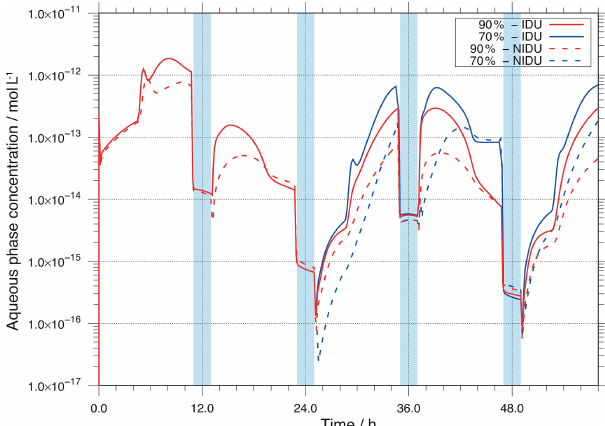
Figure 7. Modelled OH aqueous-phase concentrations in molL − 1 throughout the simulation time for the different urban simulation cases (90%-IDU / 90%-NIDU and 70%-IDU /